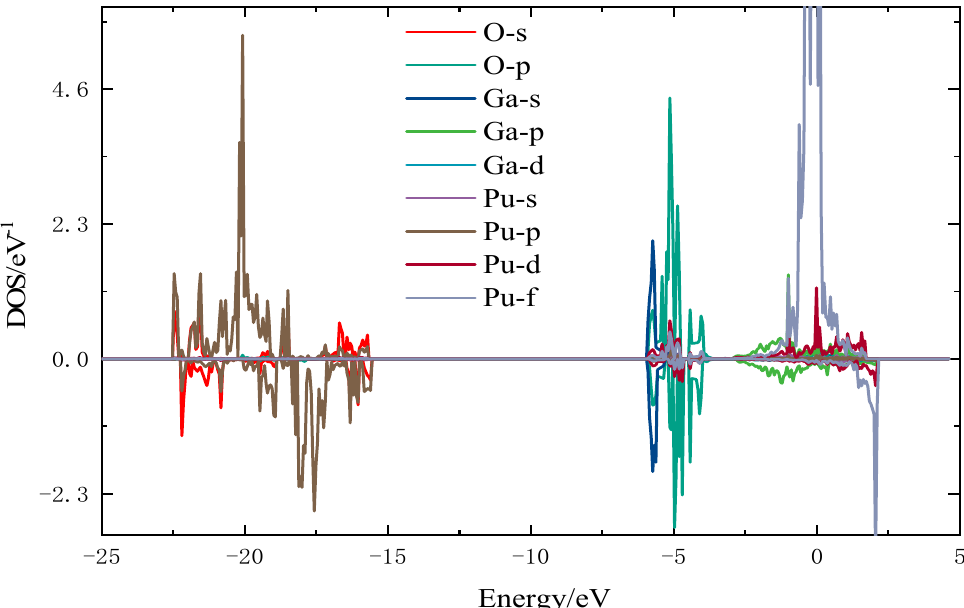
Figure 5. Fractional wave density of states for O-h-ver configuration.